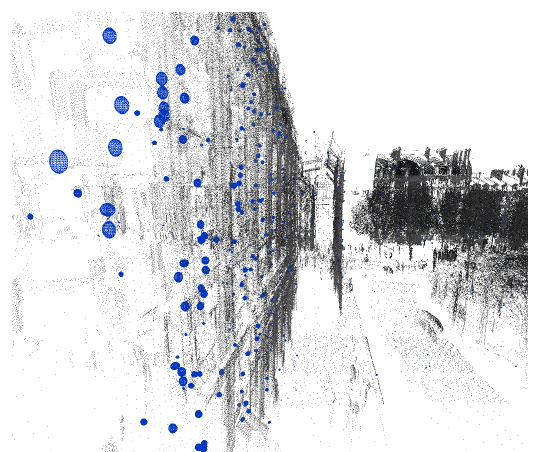
Figure 3: Black : points cloud of the mobile terrestrial LiDAR , blue : error ellipsoids. We estimate the error ellipsoid every 1000